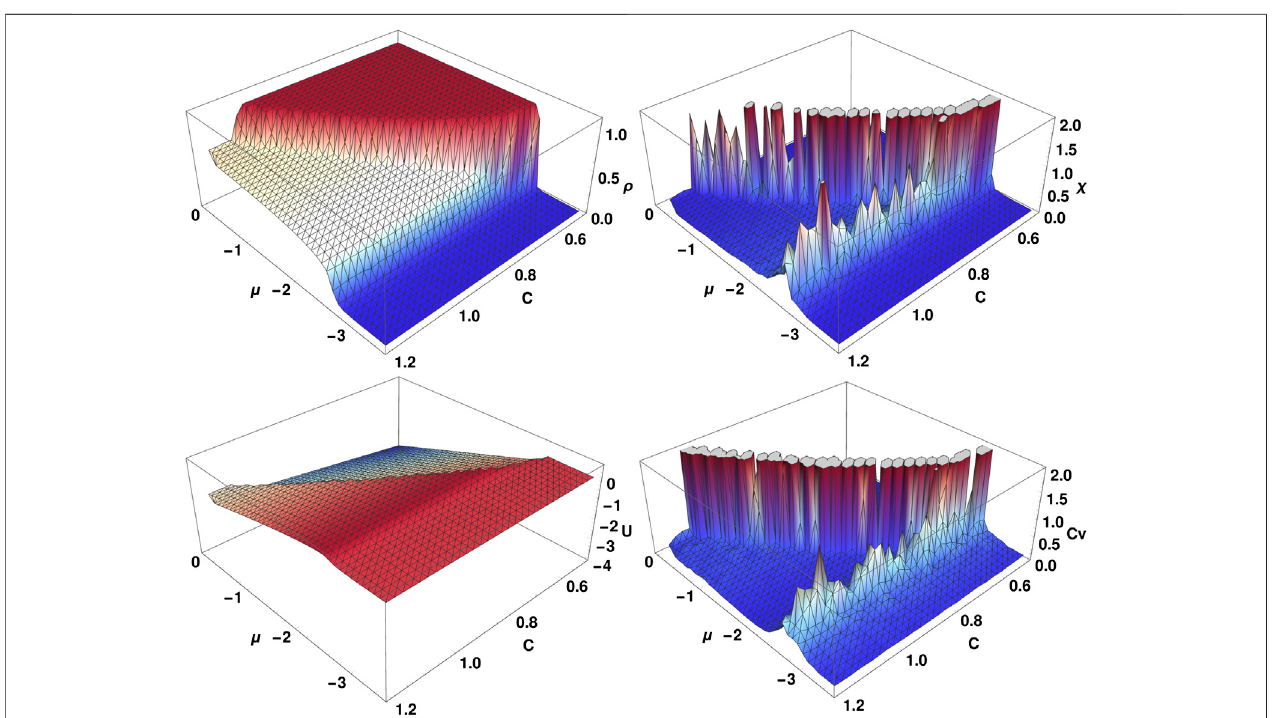
FIGURE3| Macroscopic variablesfor asquarelattice model: density ρ (top left), internalenergy U (top right),density susceptibility χ (bottom left) and heatcapacity at constant volume C V (bottom right), for L (cid:1) 40 as a function of chemical potential μ and the parameter C .